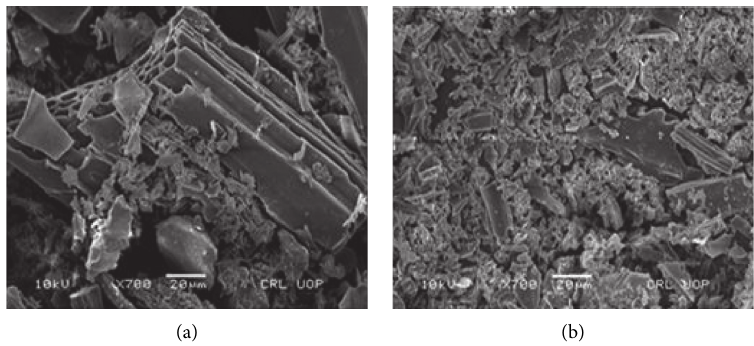
Figure 12: SEM of corn stalk ash at different grinding times: (a) 30 minutes and (b) 240 minutes.